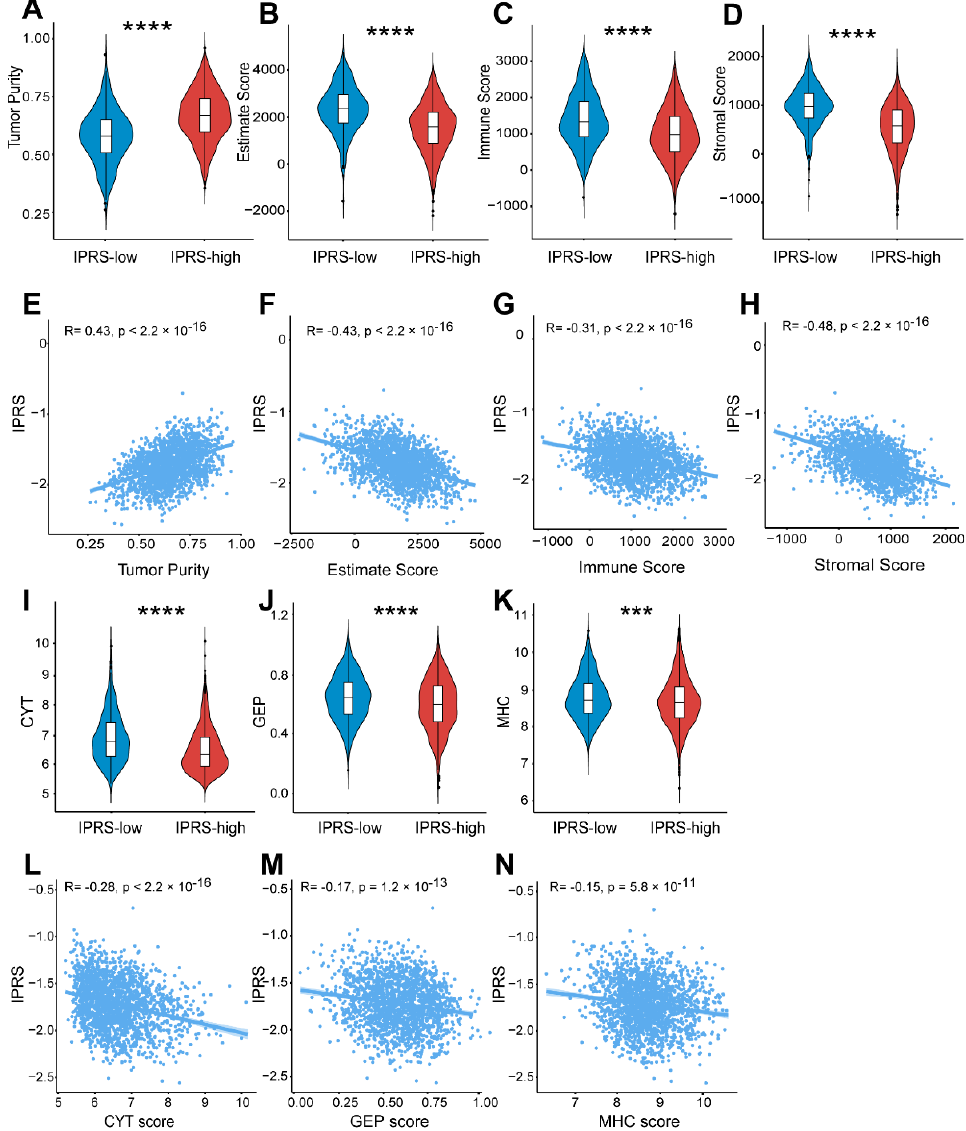
Figure 5. Correlation between the IPRS and immune-related features. ( A – D ) Comparison of the tumor purity score ( A ), estimate score ( B ), immune score ( C ), and stromal score ( D ) between the IPRS-high and IPRS-low groups. ( E – H ) Scatter plots of the linear fit of IPRS with the tumor purity score ( E ), estimate score ( F ), immune score ( G ), and stromal score ( H ). ( I – K ) Comparison of the CYT score ( I ), GEP score ( J ), and MHC score ( K ) between the IPRS-high and IPRS-low groups. ( L – N ) Scatter plots of the linear fit of IPRS with the CYT score ( L ), GEP score ( M ), and MHC score ( N ). *** p < 0.001; **** p < 0.0001.